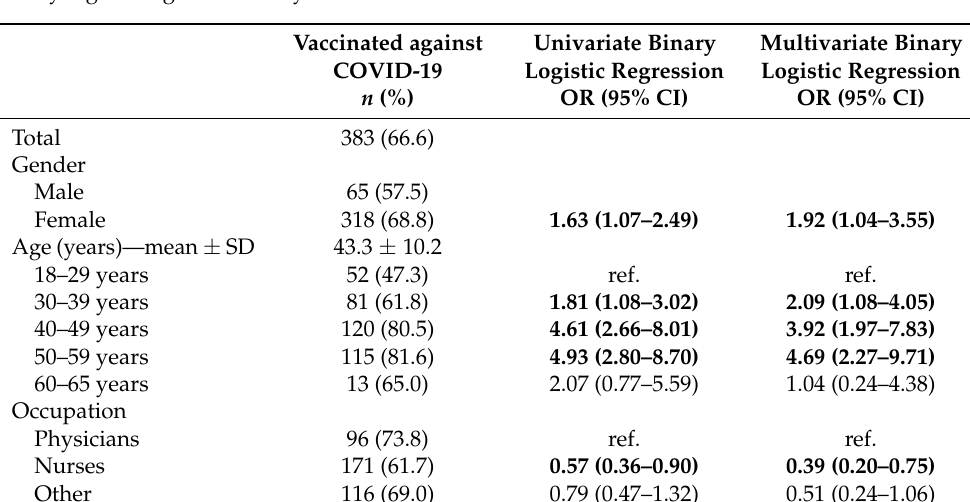
Table 3. Predictors of healthcare workers COVID-19 vaccine uptake: univariate and multivariate binary logistic regression